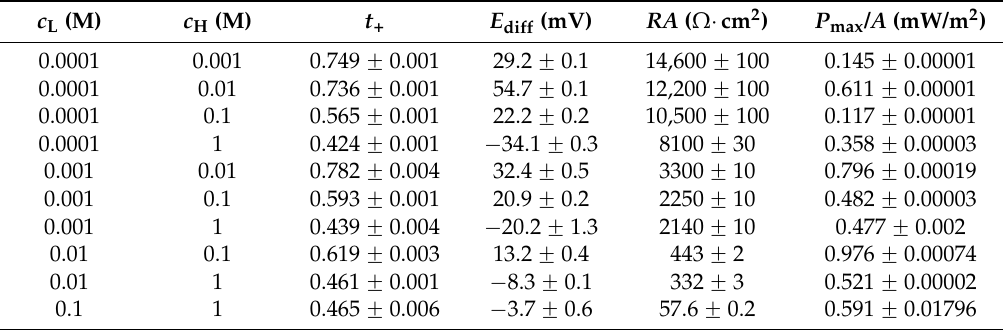
Table 1. Transference number, diffusion potential, area ‐ specific resistance, and maximum power density for various combinations of NaCl concentrations. c L (M)